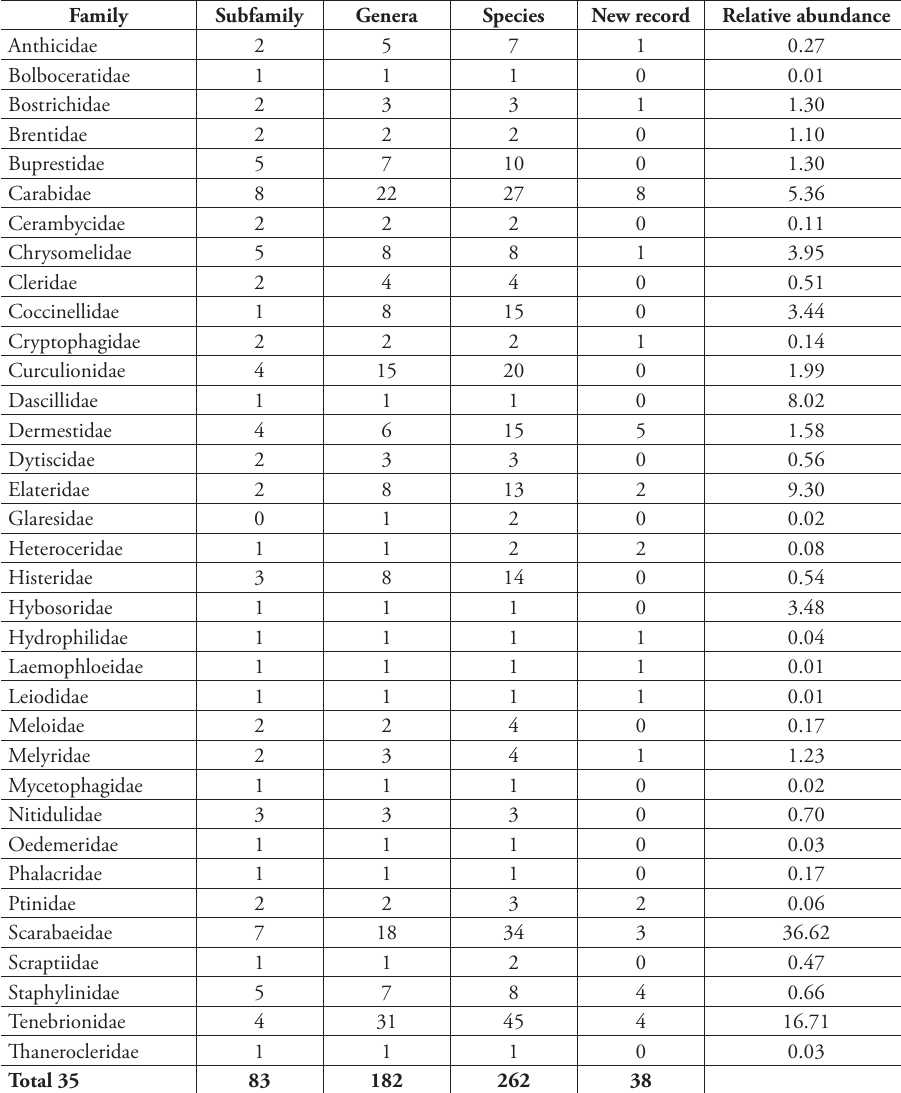
Table 1. The taxonomical and faunistic analysis of the beetle fauna in Rawdhat Khorim National Park, Central Kingdom of Saudi